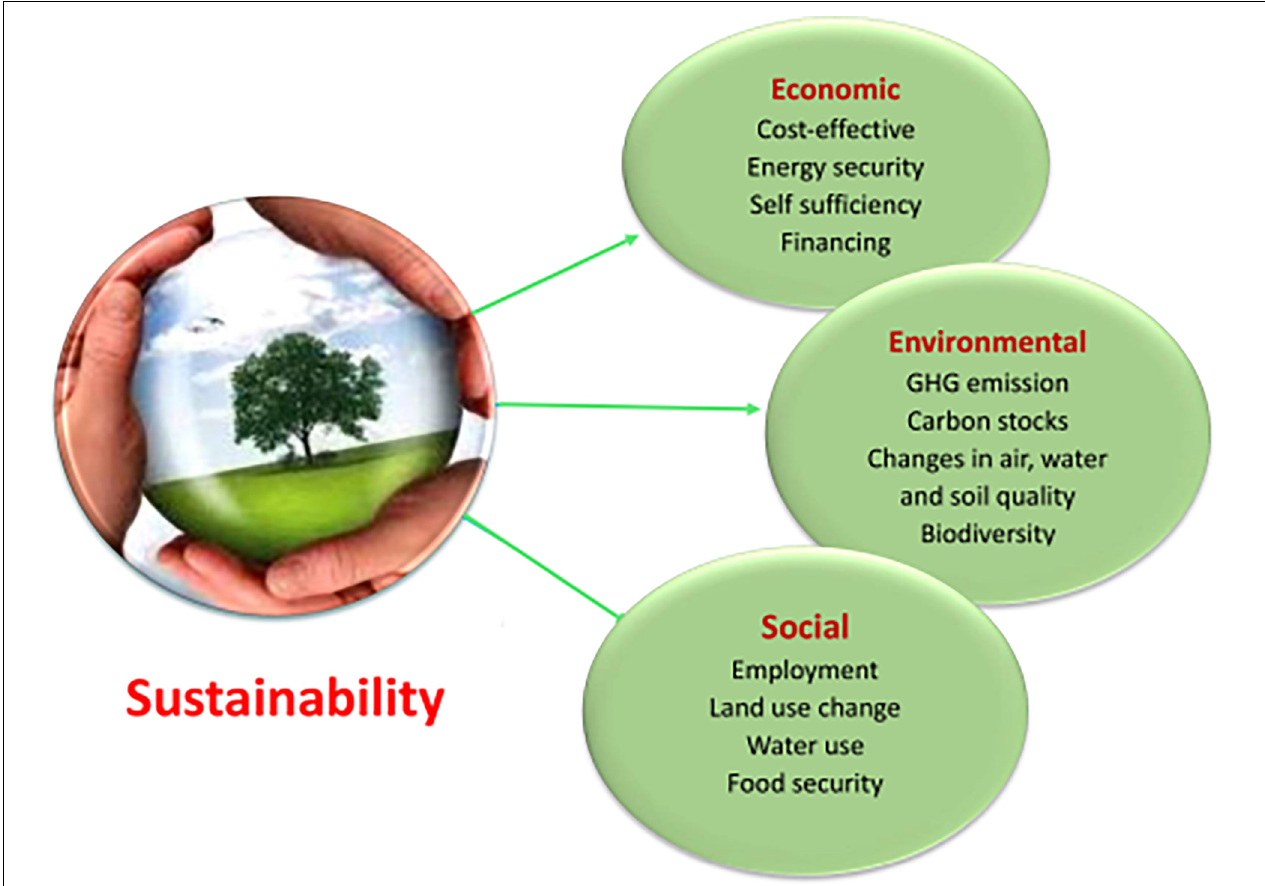
FIGURE 1 | Economic, environmental and social aspects of sustainable biofuels.